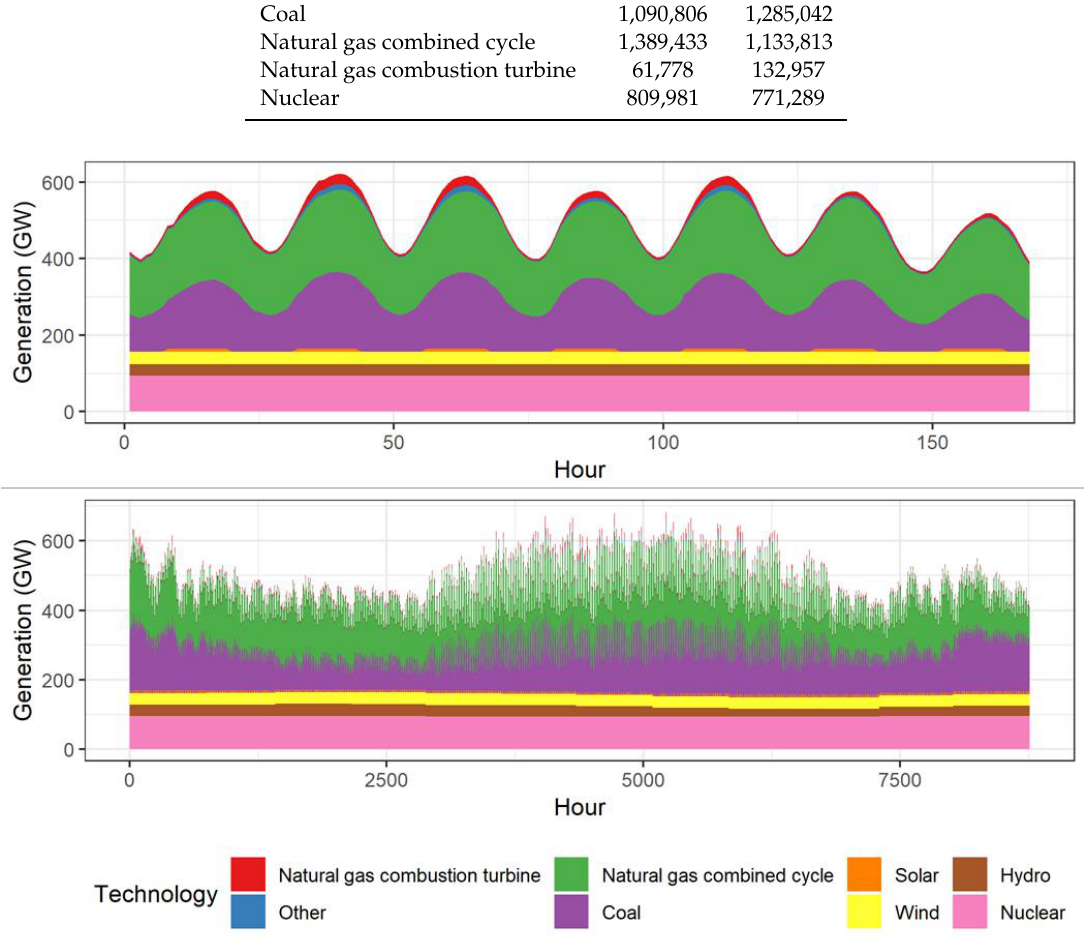
Figure 4. Modeled U.S. electricity production for the first week of July (top) and the full year (bottom).